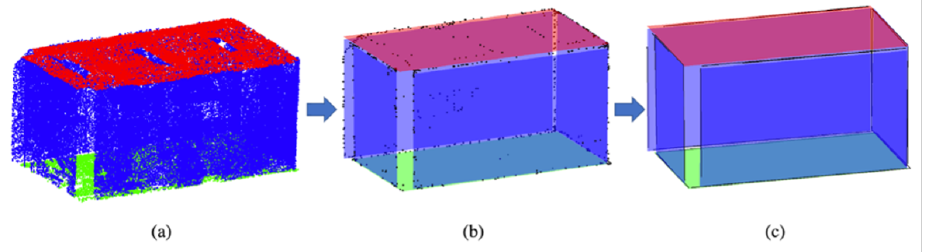
Figure 2. Example of primitive extraction with boundary: ( a ) semantic patches with uniform density (red: ceiling points, blue: wall points, and green: floor points); ( b ) geometric model and the points belonging to boundary (black points); and ( c ) black lines denote the boundary lines for each planar